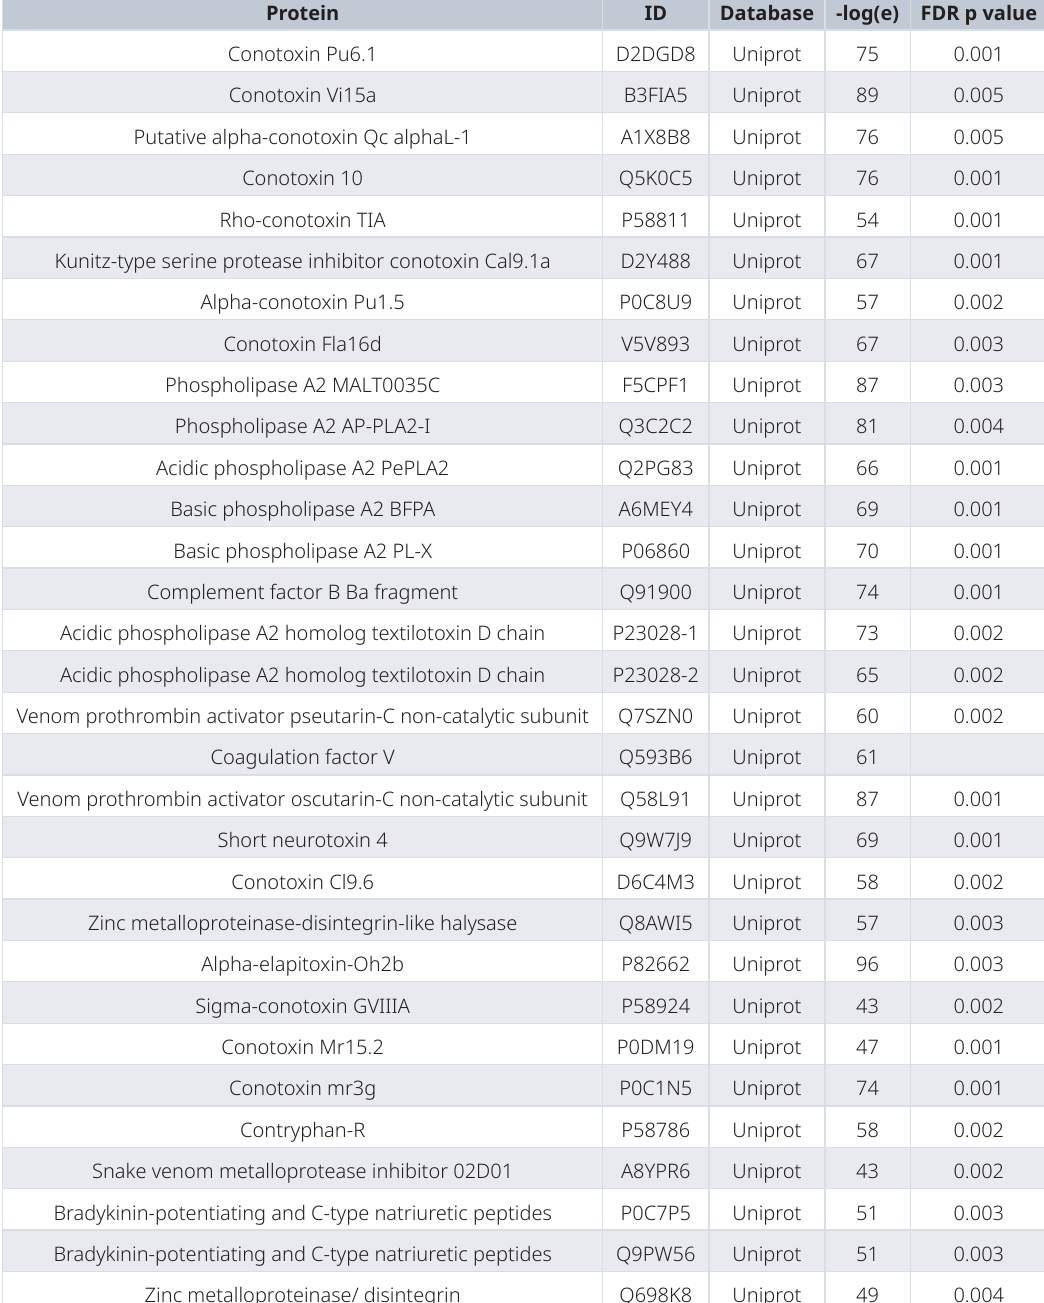
Table 2. List of proteins and the related -log(e) and false discovery ratio (FDR) expressed as p